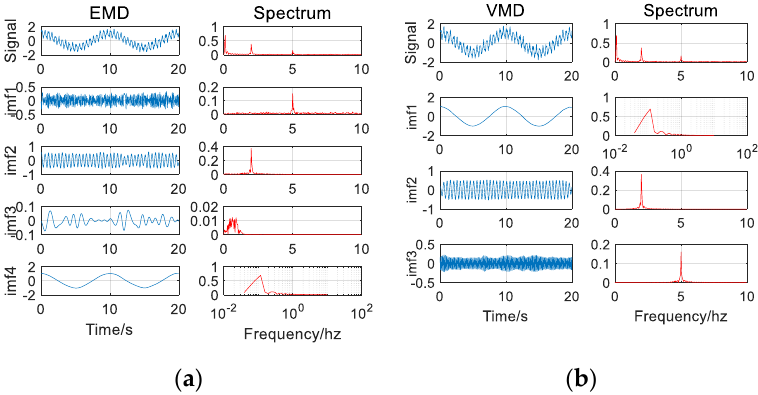
Figure 6. (a) The EMD decomposition results of the signal (with noise); (b) The VMD decomposition results of the signal (with noise).